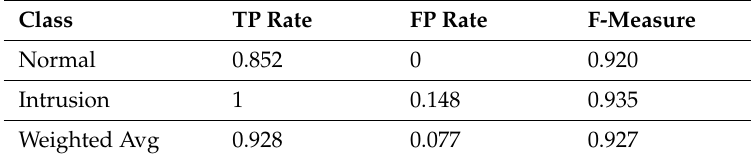
Table 11. Detailed accuracy of using one class SVM.